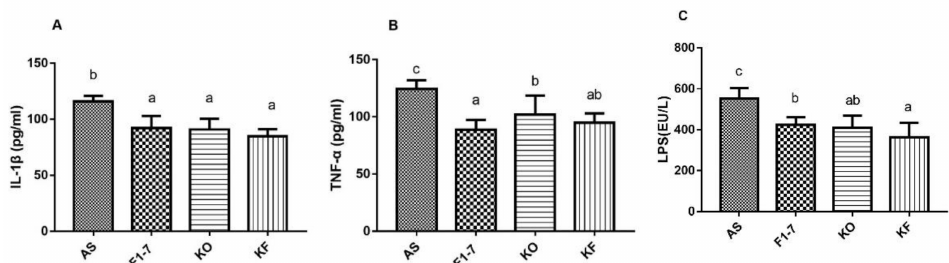
Figure 6. The plasma IL-1 β ( A ), TNF- α ( B ), and LPS ( C ) levels were measured by ELISA (n = 5). There were statistically significant differences between groups of different letters, p <